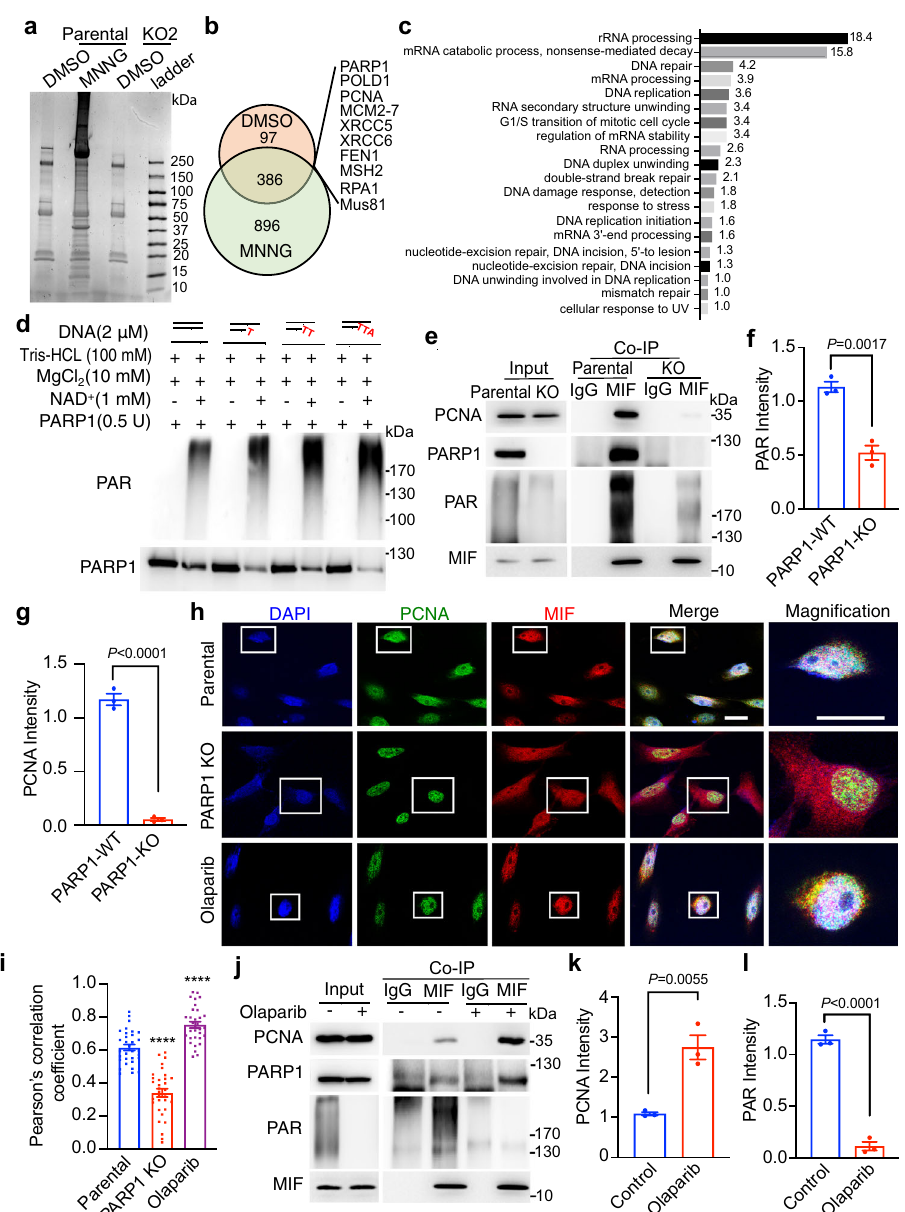
Fig. 5 PARP1 is required for the recruitment of MIF to DNA replication sites. a Immunoprecipitation of endogenous MIF in parental and MIF KO HeLa cells under physiological conditions (DMSO) as well as 4 h after DNA damage (MNNG, 50 μ M, 15 min). b Mass spectrometry analysis of MIF-interacting proteins in HeLa cells under physiological conditions (DMSO) as well as 4 h after DNA damage. c Functional annotation of overlapped MIF-interacting proteins under both physiological and DNA damage conditions using David Bioinformatics Resources 6.8. Values indicate the % of proteins detected in the database. Pathways with P < 0.05 were listed. d In vitro PARylation assay by incubating PARP1 with dsDNA containing 0 – 3 mismatched nucleotides at the 3 ′ end in the presence of 1 mM NAD + and 10 mM MgCl 2 . Representative blots from three independent experiments are shown. e – g Co-IP of MIF and PCNA in parental and PARP1 KO MDA-MB-231 cells. Relative PAR and PCNA intensities were quanti fi ed and shown in f and g , respectively (mean± SEM, n = 3 biologically independent experiments). Statistical signi fi cance was determined by two-tailed Student ’ s t test. h , i Immunostaining of MIF and PCNA in parental, PARP1 KO and Olaparib-treated (5 μ M, 2 h) MDA-MB-231 cells 2 h following double thymidine synchronization. White indicates colocalization. Representative images from three independent experiments are shown in h . Scale bar, 20 μ m. The Pearson ’ s correlation coef fi cient of MIF-PCNA colocalization was quanti fi ed and shown in i (mean ± SEM, n = 32 cells per group over three independent experiments). Cells with Pearson ’ s correlation coef fi cient ( r ) >0.5 is considered as the positive correlation of MIF-PCNA colocalization, r > 0.7 is considered as a strong correlation and r < 0.4 is considered as a weak or no correlation. **** P < 0.0001 compared to parental cells, by one-way ANOVA Dunnett ’ s multiple comparisons test. j Co-IP of MIF, PCNA, PAR, and PARP1 in MDA-MB-231 cells treated with or without Olaparib (5 μ M, 2 h) following double thymidine synchronization. k , l Relative intensities of PCNA and PAR were quanti fi ed and shown in k and l , respectively (mean ± SEM, n = 3 biologically independent experiments). Statistical signi fi cance was determined by two-tailed Student ’ s t